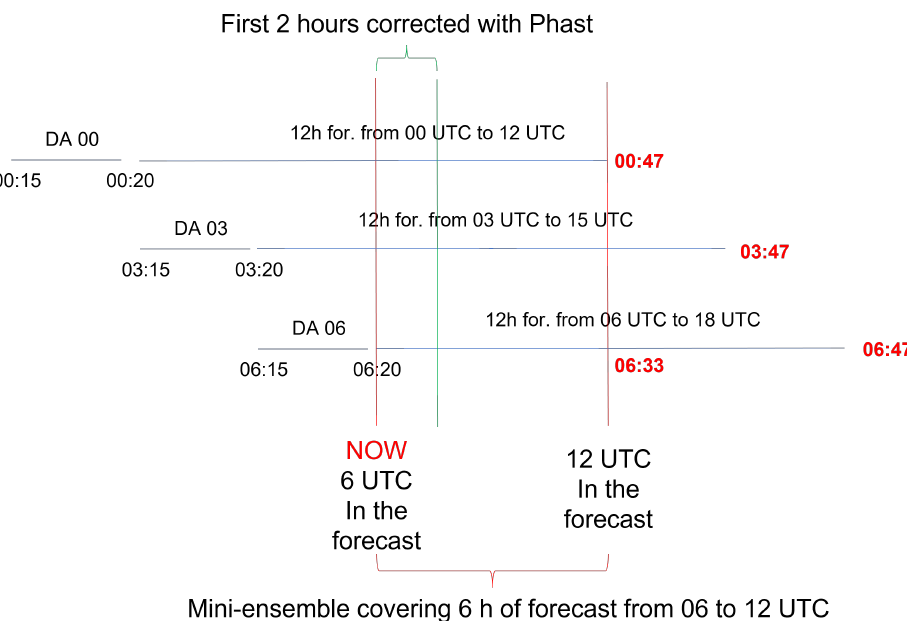
Figure 3. Ensemble example from timing reported in Figure